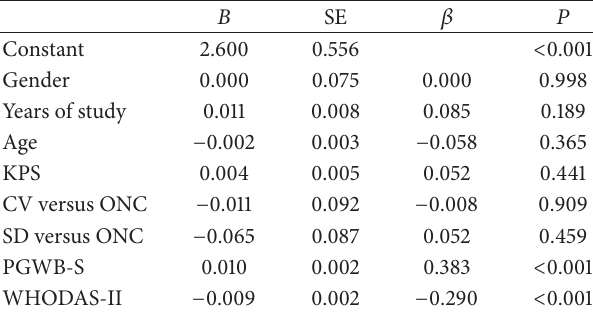
Table 6: Relationship between gender, years of study, age, KPS, diagnosis, PGWB-S, WHODAS-II, and EUROHIS-QoL in the whole sample.